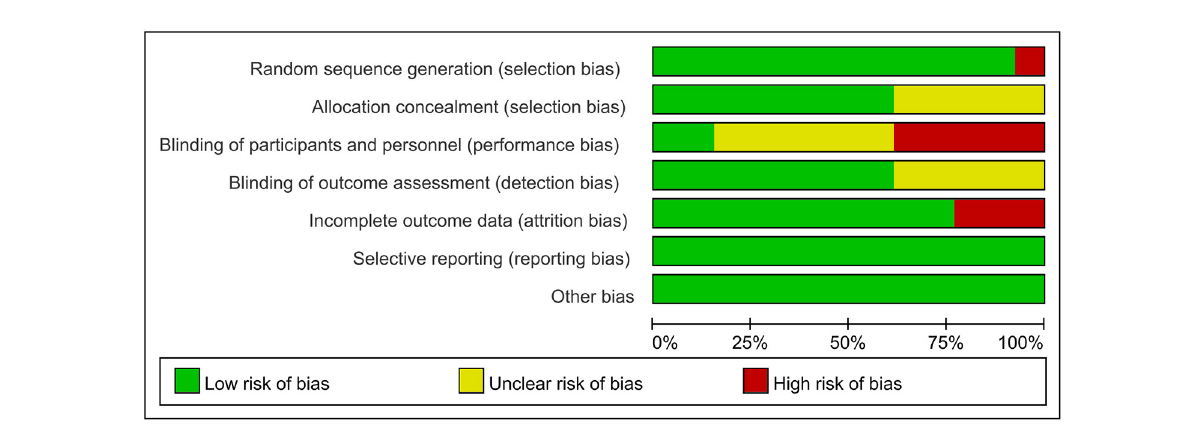
FIGURE2 Evaluation of the quality of included